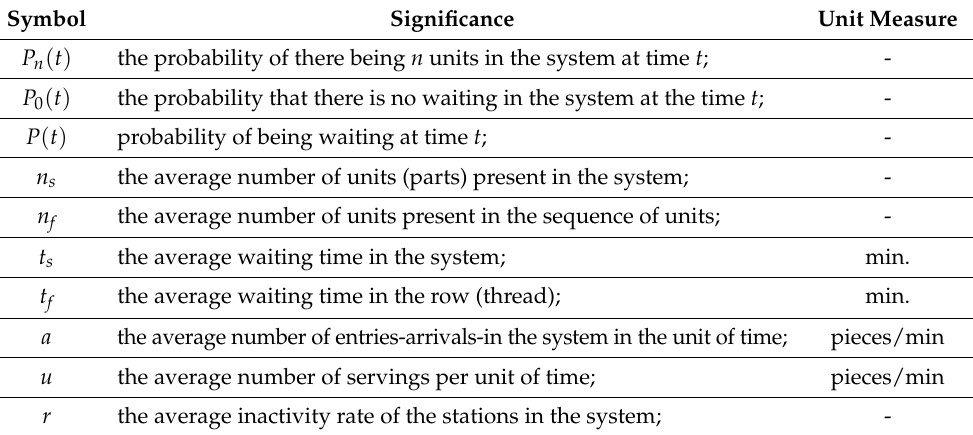
Table 1. The list and significance of notations